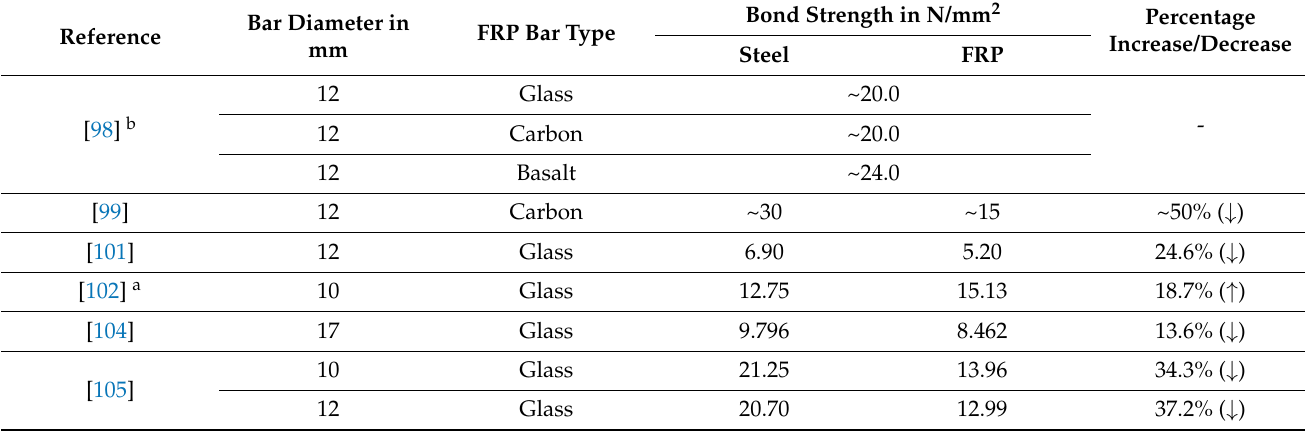
Table 5. Effect of FRP bar type on bond